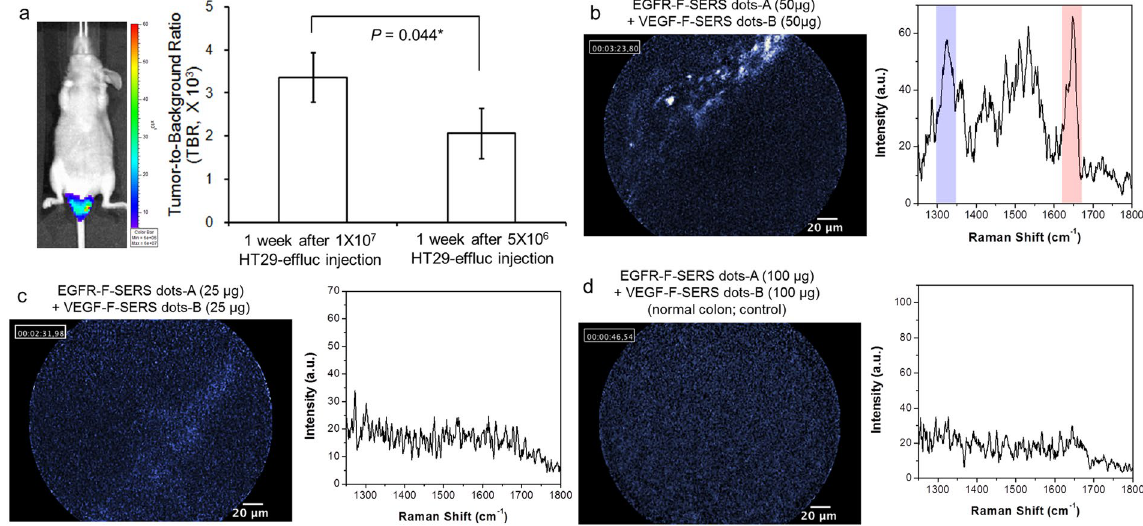
Figure 6. Evaluation of sensitivity and lower dose limit of FRES. ( a ) Orthotopic CRC xenograft modeling for small tumors. After one week of injecting 5 × 10 6 HT29-effluc cells in mice, bioluminescence imaging showed mild-to-moderate activity in the colorectal area (left). A significantly lower TBR was found compared with that of mice one week after injecting 1 × 10 7 HT29-effluc cells (2,055 ± 578 vs. 3,354 ± 568, P = 0.044 * ) (right). ( b ) After spraying 50 µ g of EGFR-F-SERS-A and VEGF-F-SERS-B dots onto small tumors in a CRC xenograft model, fluorescence signals were observed, and two corresponding Raman signals [RITC (-A) and FITC (-B)] were found. ( c ) On the other hand, after spraying 25 µ g each of EGFR-F-SERS-A and VEGF-F-SERS-B dots, a faint fluorescence signal and no Raman signal was found in some cases (20%, 2/10). ( d ) In the normal colon (control), no fluorescence or Raman signals were found corresponding EGFR-F-SERS-A and VEGF-F-SERS-B